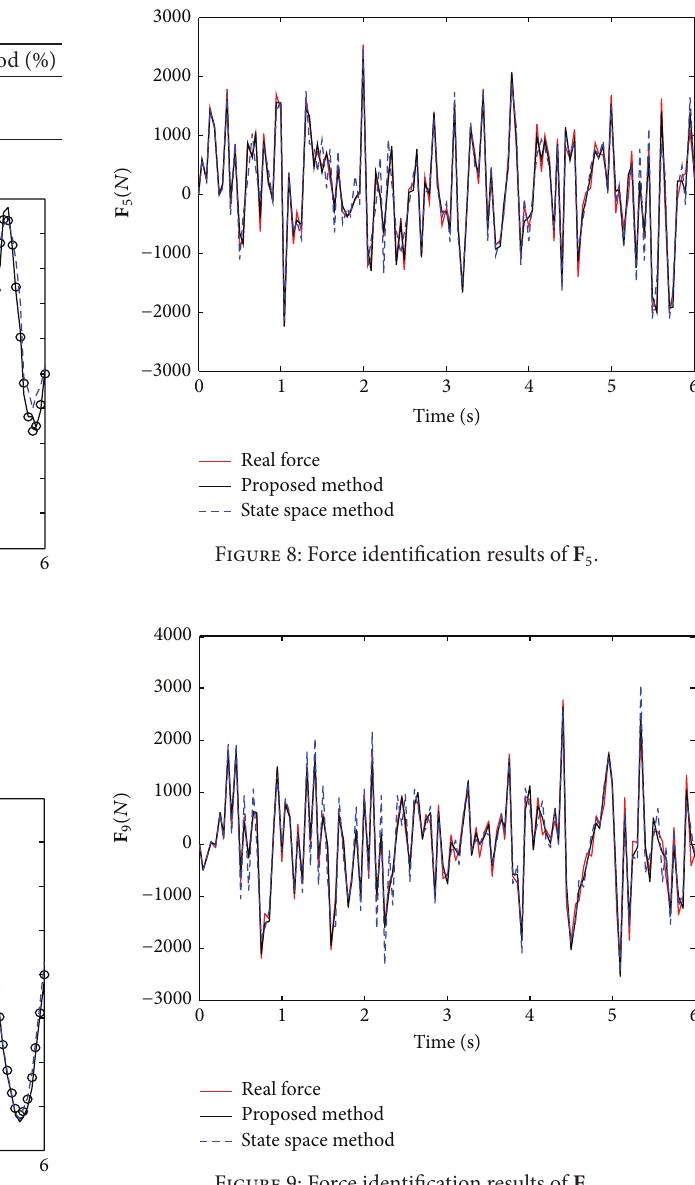
Figure 9: Force identification results of F 9